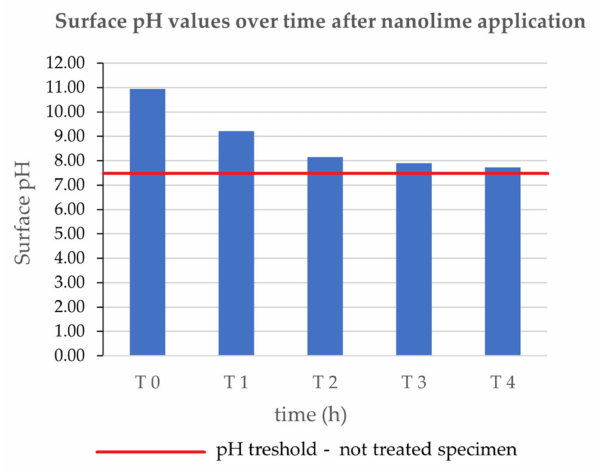
Figure 6. pH values over time on specimens. The red line represents the pH value of the untreated specimens ( pH threshold ).